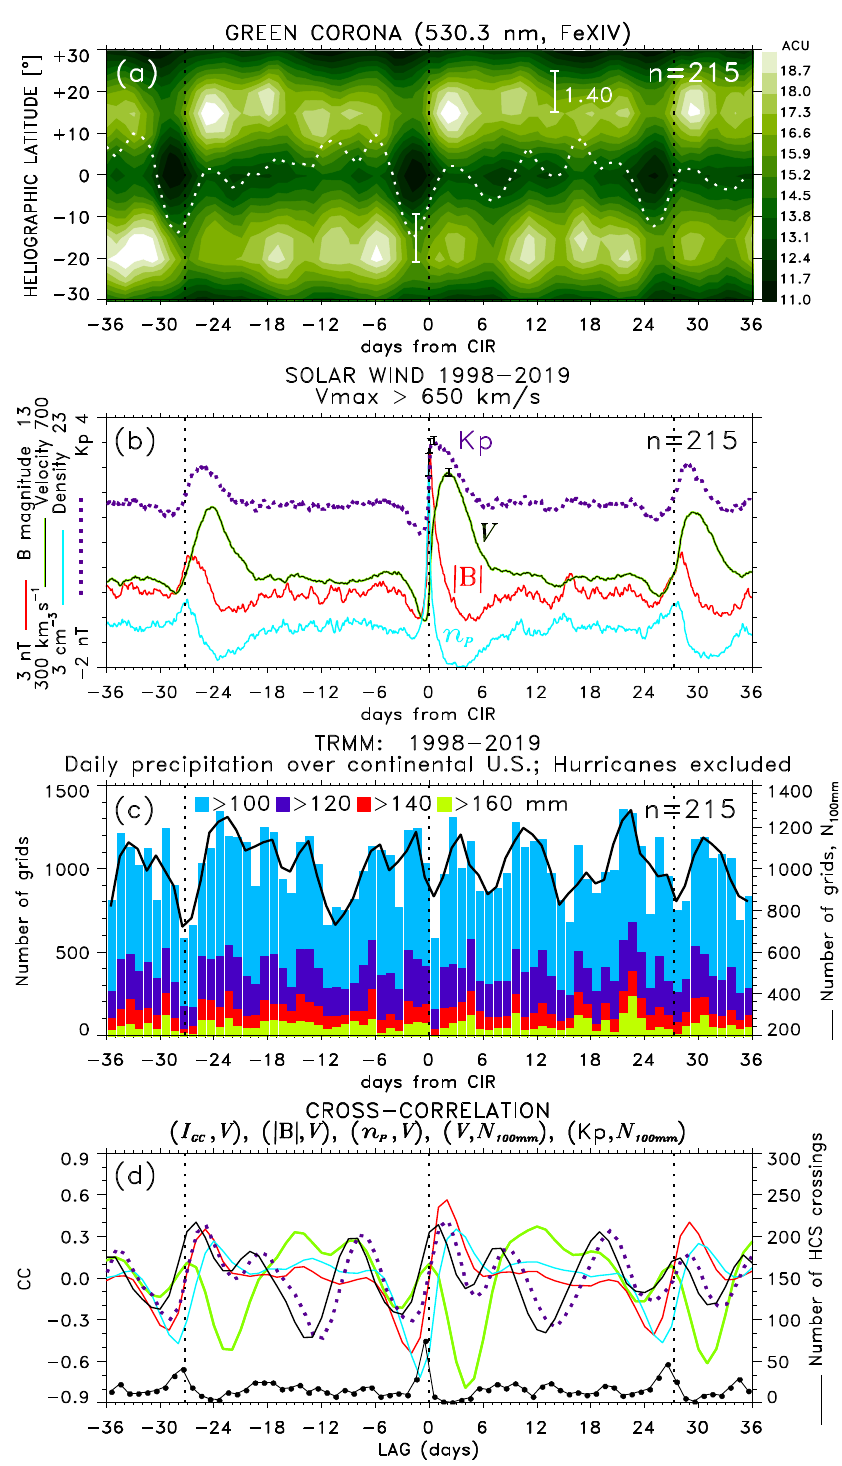
Figure 7. The SPE analysis for the period from 1998 to 2019 of ( a ) green corona intensity and ( b ) solar wind plasma variables keyed to the arrivals of major HSS/CIRs ( V max > 650 km/s) for periods of ± 36 days relative to the key time. ( c ) The cumulative number of TRMM grid cells over the continental U.S. with above-threshold daily precipitation rates and days of hurricane impacts excluded. ( d ) The cross-correlation function computed for the solar wind velocity V paired with the rest of the variables, ( I GC , V ) in green, ( n p , V ) in light blue, ( B , V ) in red, ( Kp , smoothed N 100mm ) in dotted purple, and (smoothed N 100mm , V ) in black. The cumulative number of HCS crossings for each epoch day is shown by black